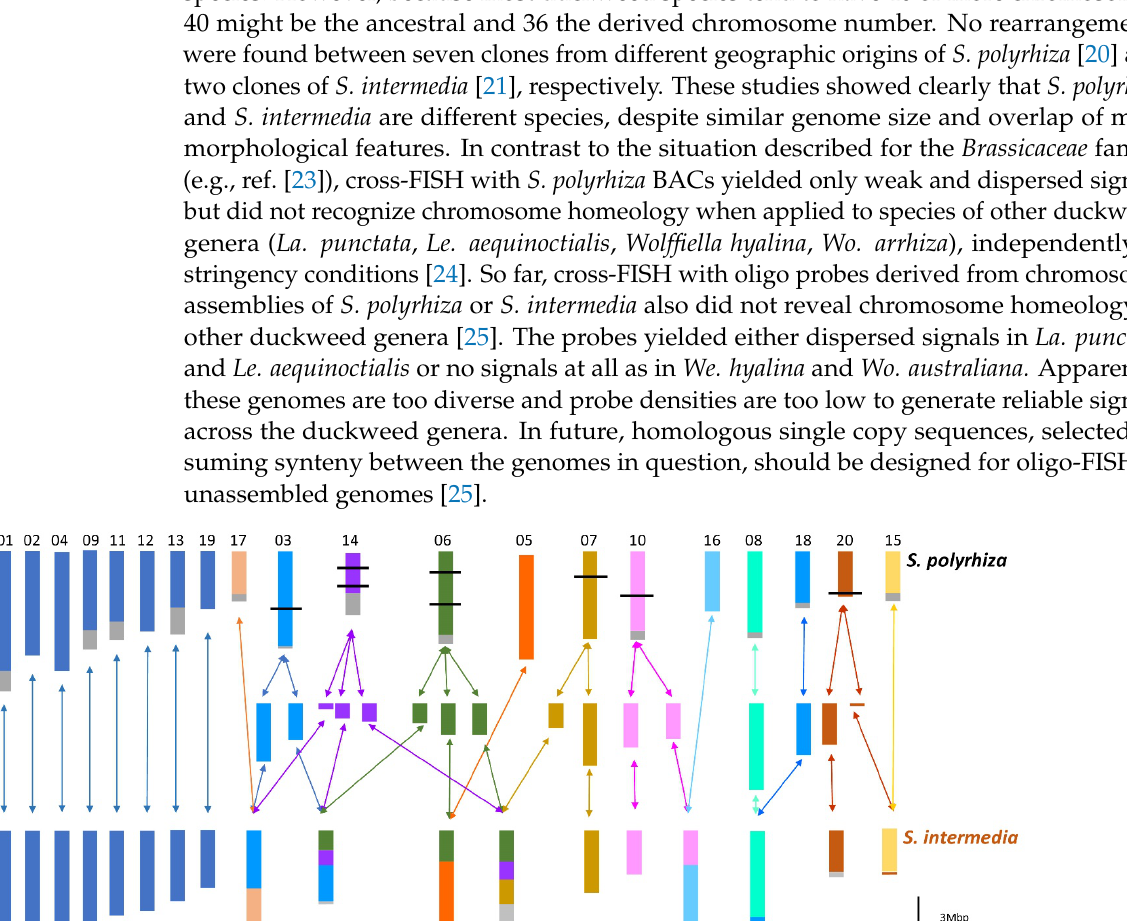
Figure 3. Chromosome homeology and rearrangements between S. polyrhiza ( n = 20) and S. intermedia ( n = 18) as revealed by cytogenomics, see [21,22]. The double arrows indicate that either direction of evolution could have happened. Dark blue are chromosomes not involved in rearrangements; other colors indicate rearranged chromosomes. Dark grey boxes: regions present only in S. polyrhiza ; light grey boxes: regions present only in S. intermedia. Enumeration indicates distinct chromosomes of the respective